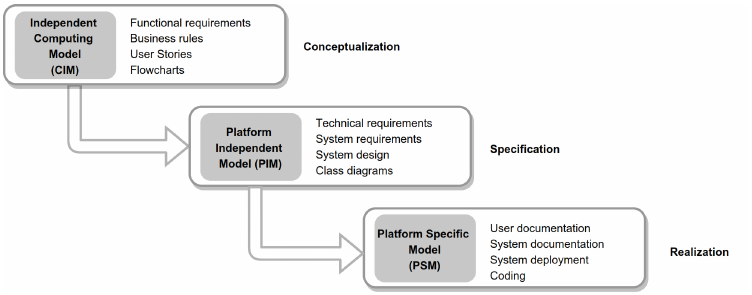
Figure 4. Model-Driven Architecture (MDA)